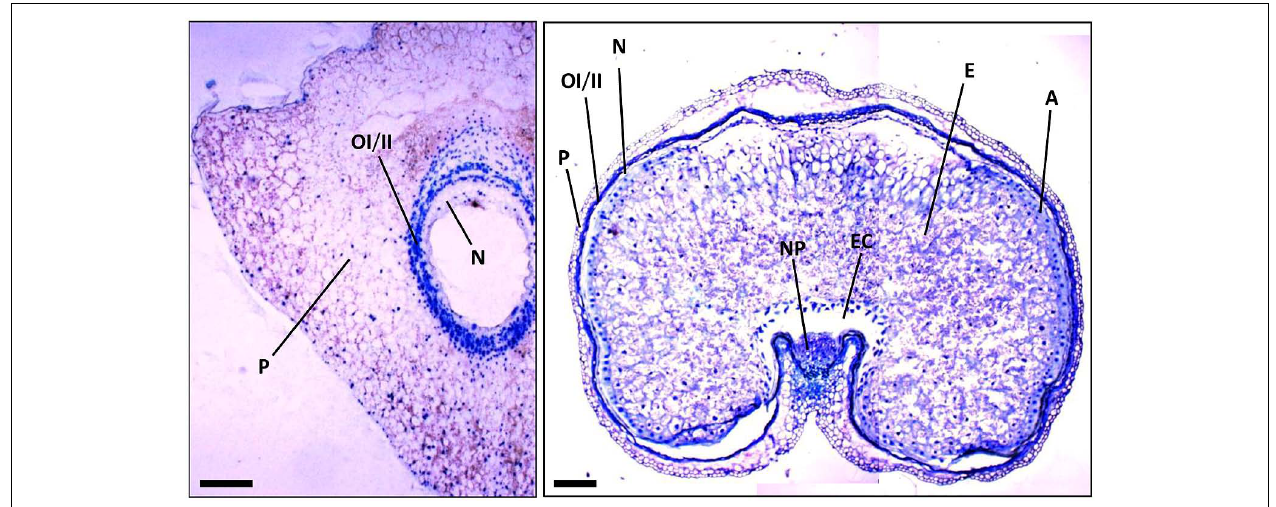
FIGURE 2 | Sections of wheat seeds at 3 DPA (left) and 16 DPA (right) stained with toluidine blue. Note the different tissues and how they change between these stages of seed development. P, pericarp; OI,